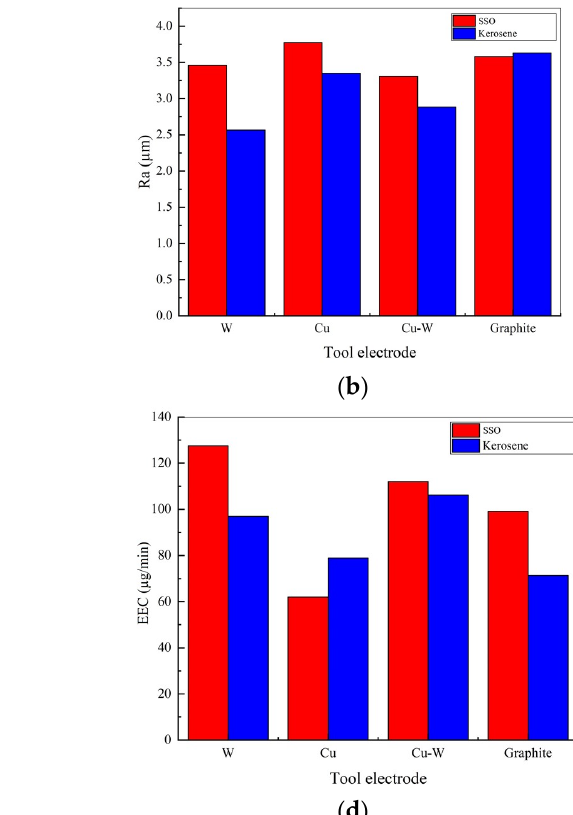
Figure 7. Processing performance comparison of electrodes in SSO and kerosene; ( a ) MRR comparison of electrodes in SSO and kerosene; ( b ) EEV comparison of electrodes in SSO and kerosene; ( c ) Ra comparison of electrodes in SSO and kerosene; ( d ) Comparison of electrode EEC in SSO and